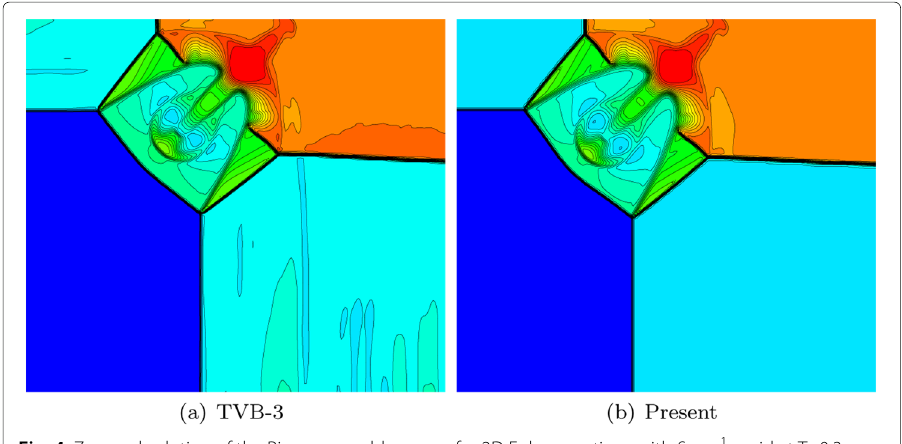
Fig. 4 Zoomed solution of the Riemann problem case for 2D Euler equations with S − 1 under RKDG(p2)